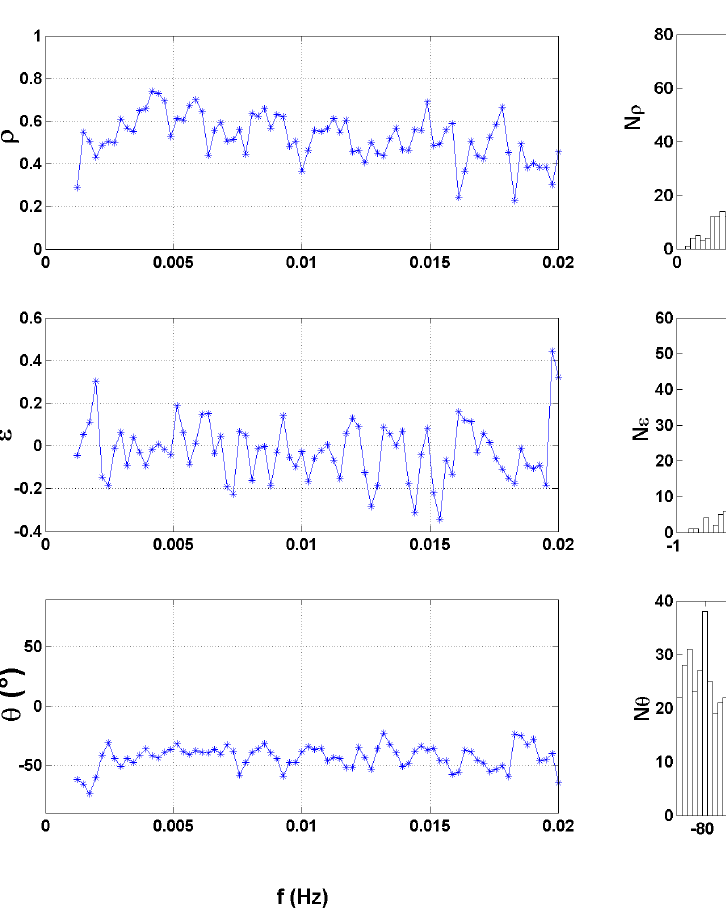
Figure 11. Enlargement of the coherence analysis in the frequency band up to 20 mHz.